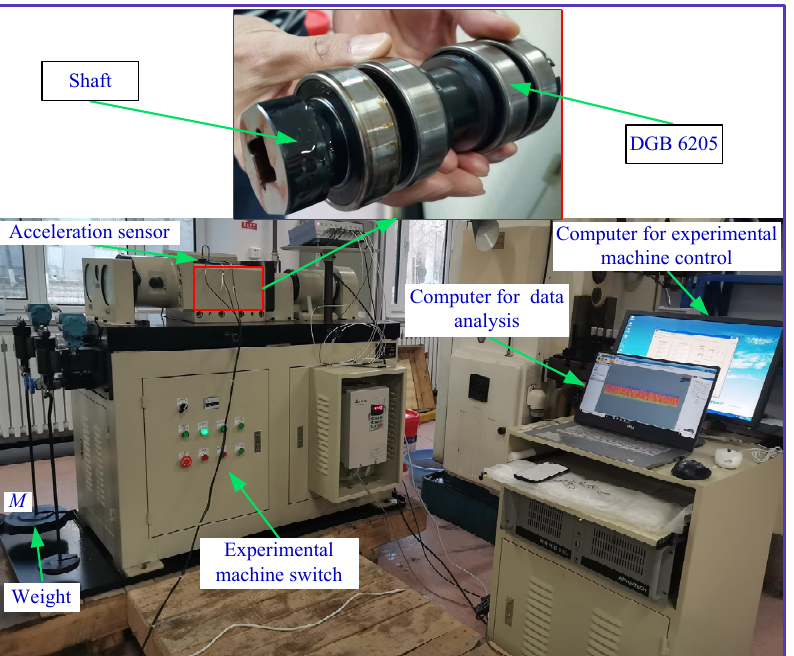
Figure 4. ABLT-1A bearing experimental machine.